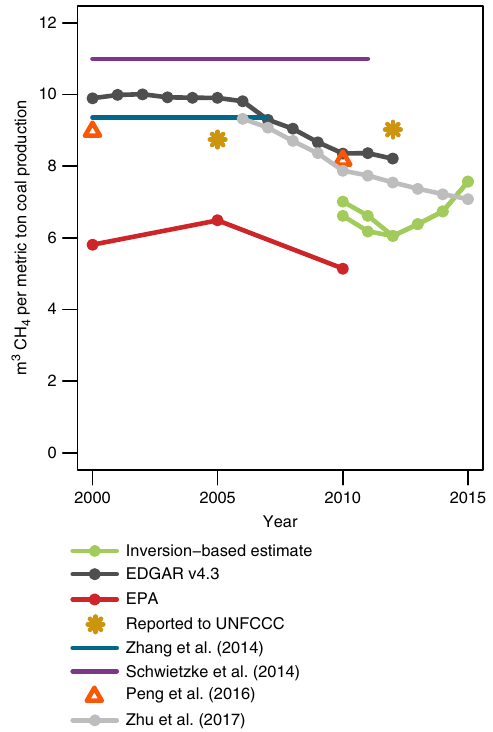
Fig. 6 Coal CH 4 emissions factors. Emissions factors implied by this study, EDGAR v4.3 4 , US EPA 9 , UNFCCC 35 , Zhang et al. 54, Schwietzke et al. 55, Peng et al. 6, and Zhu et al. 7 . The factors implied by this study are in the lower mid-range of existing estimates. In some cases, we divide total emissions by coal production numbers to derive emissions factors for this fi gure. For example, we divide the EDGAR emissions estimate by EIA coal production estimates 1 , and we divide Peng et al. 6 and China ’ s UNFCCC report by production numbers from China ’ s Statistical Yearbook 8 , the production numbers used in those estimates. The two green lines in this fi gure are the inversion estimate divided by production numbers from EIA and China ’ s Statistical Yearbook, respectively. Note that Schwietzke et al. 55 and Zhang et al. 54 use time-invariant emissions factors, and these studies are therefore represented with solid